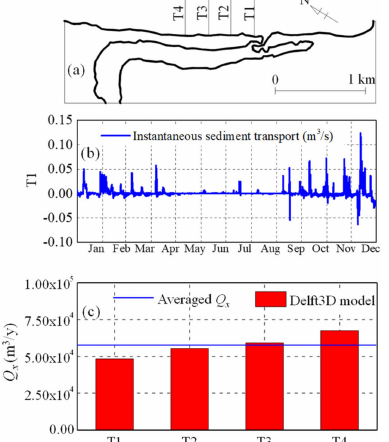
Figure 10. ( a ) Location of profiles. ( b ) Instantaneous sediment transport rate through the T1-profile. ( c ) Total cumulative sediment transport through 4 profiles at the Ly Hoa sand